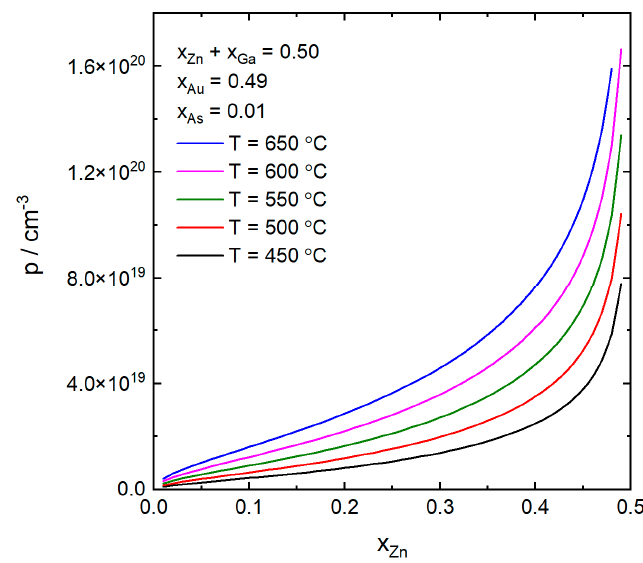
Figure 2. The p-doping concentration as a function of the atomic fraction of Zn in the catalyst particle Figure 2. The p ‐ doping concentration as a function of the atomic fraction of Zn in the catalyst particle Figure 2. The p ‐ doping concentration as a function of the atomic fraction of Zn in the catalyst particle at various temperatures, from 450 to 650 ◦ C. The atomic fractions of As and Au were kept constant at various temperatures, from 450 to 650 °C. The atomic fractions of As and Au were kept constant at at various temperatures, from 450 to 650 °C. The atomic fractions of As and Au were kept constant at at x As = 0.01 and x Au = 0.49. The atomic fraction of Zn was varied at the expense of Ga so that 𝑥 (cid:2885)(cid:2929) (cid:3404) 0.01 and 𝑥 (cid:2885)(cid:2931) (cid:3404) 0.49 . The atomic fraction of Zn was varied at the expense of Ga so that 𝑥 (cid:2910)(cid:2924) (cid:3397) 𝑥 (cid:2885)(cid:2929) (cid:3404) 0.01 and 𝑥 (cid:2885)(cid:2931) (cid:3404) 0.49 . The atomic fraction of Zn was varied at the expense of Ga so that 𝑥 (cid:2910)(cid:2924) (cid:3397) x Zn + x Ga = 0.50. 𝑥 (cid:2891)(cid:2911) (cid:3404) 0.50 . 𝑥 (cid:2891)(cid:2911) (cid:3404) 0.50 .